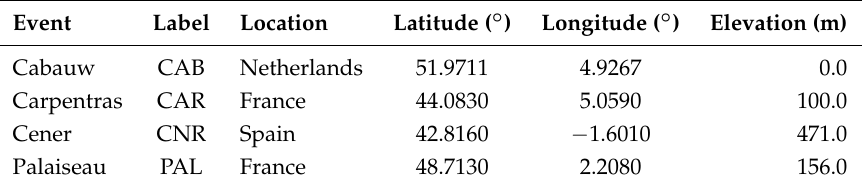
Table A1. List of BSRN pyranometer stations in the region of Europe. The stations that did not measure the radiation or deliver the data for the period of our study were not listed.